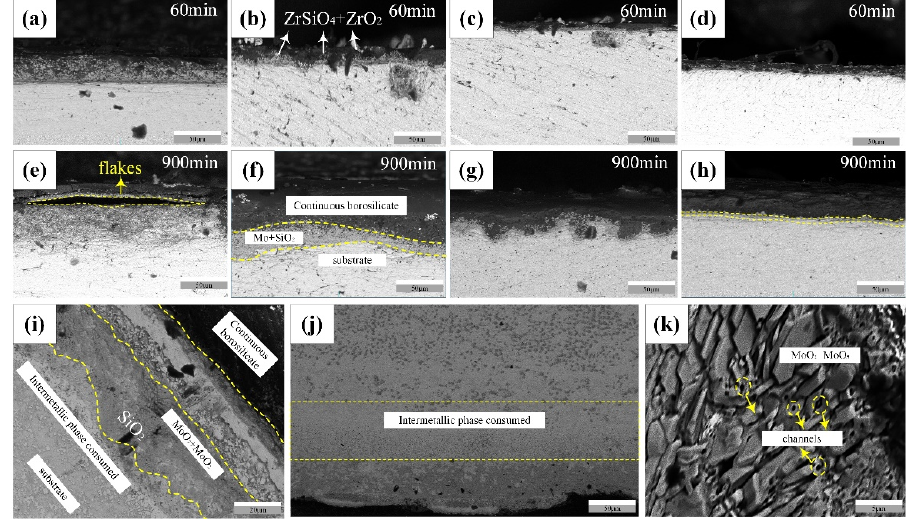
Figure 9. Oxidation profile at different time scales: ( a , e ) MSB_0ZrB 2 , ( b , f ) MSB_0.5ZrB 2 , ( c , g ) MSB_1.5ZrB 2 , ( d , h ) MSB_2.5ZrB 2 , ( i ) MSB_0.5ZrB 2 alloy oxide layer delamination; ( j ) The consumption of intermetallic phase of the MSB_0ZrB 2 alloy and ( k ) molybdenum oxide product of the MSB_0ZrB 2 alloy. Table 3. Calculated borosilicate layer thickness for selected alloys.